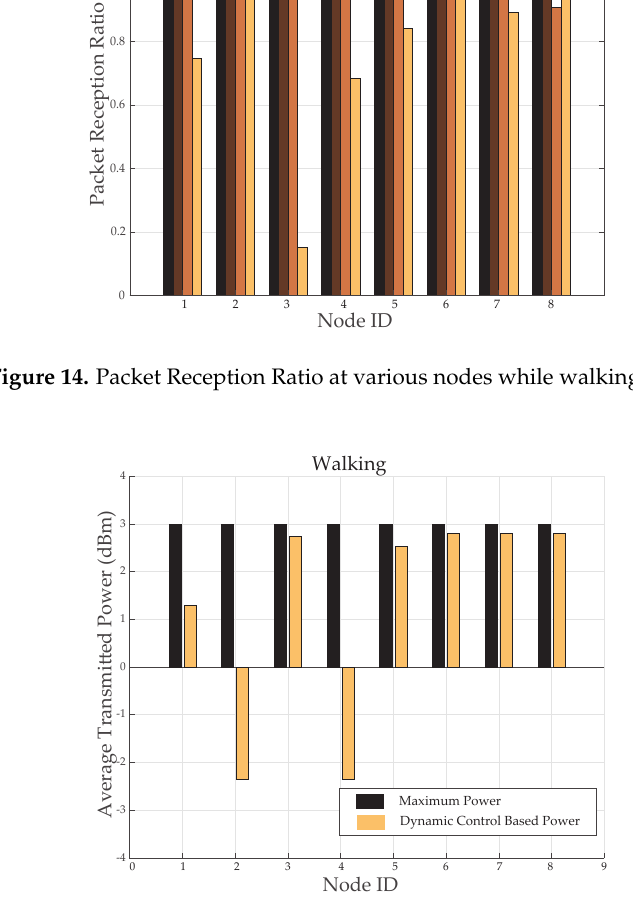
Figure 15. Average TX power consumption while walking